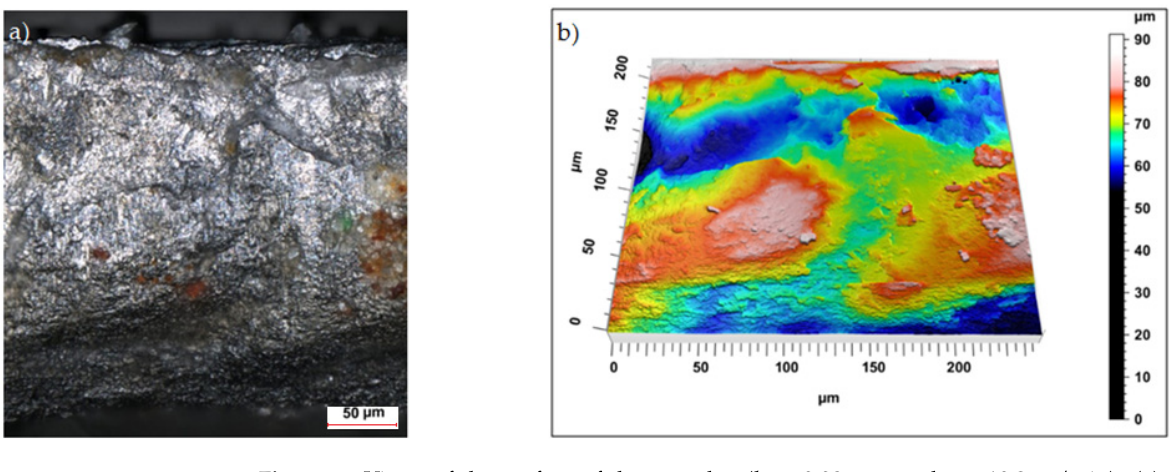
Figure 6. Views of the surface of the cut edge ( h c = 0.08 mm and v = 10.2 m/min): ( a ) surface photography, ( b ) surface topography (coated steel).